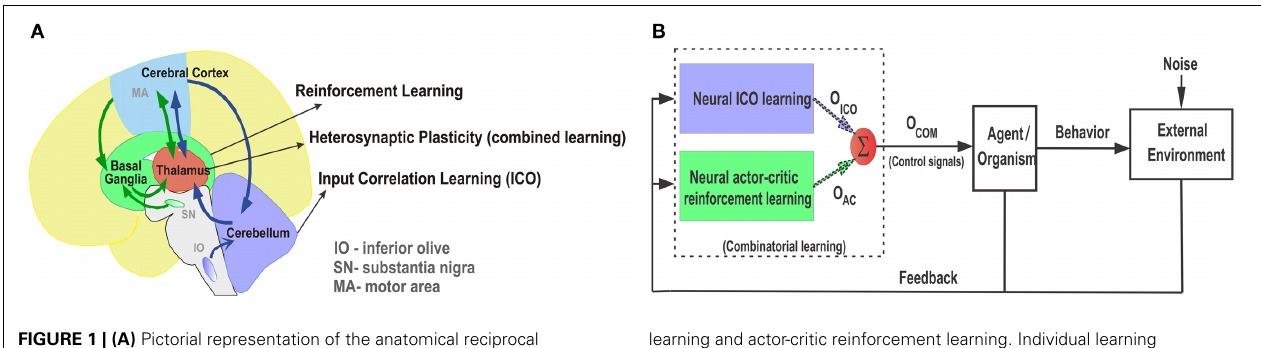
learning and actor-critic reinforcement learning. Individual learning mechanisms adapt their weights independently and then their final weighted outputs ( O ico and O ac ) are combined into O com using a reward modulated heterosynaptic plasticity rule (dotted arrows represent plastic synapses). O com controls the agent behavior (policy) while sensory feedback from the agent is sent back to both the learning mechanisms in